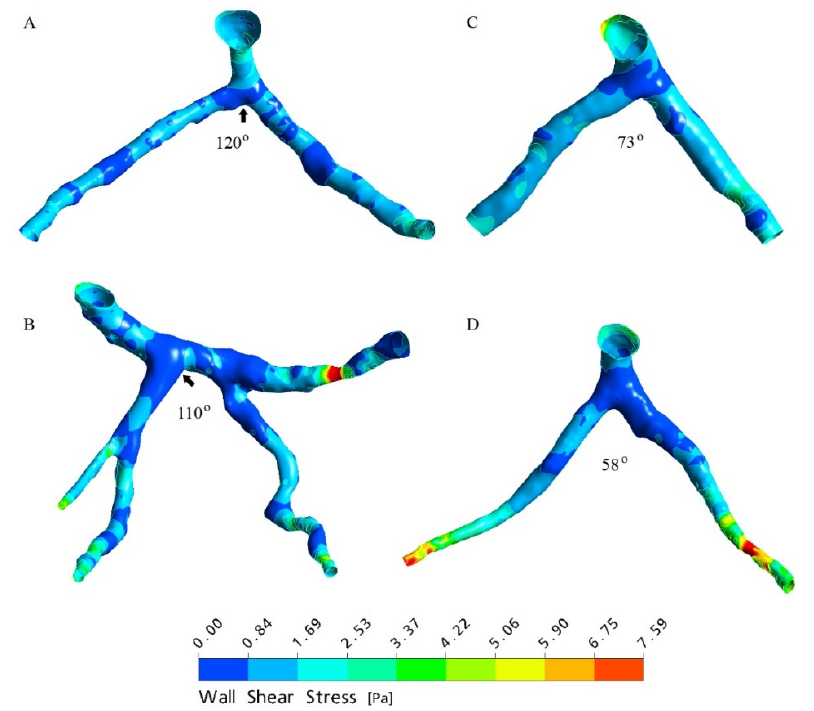
Figure 7. Wall shear stress observed with variable angles of the realistic left coronary artery models generated at peak systolic phase of 0.4 s. ( A ) and ( B ) refer to models with wide LAD-LCx angles, while ( C ) and ( D ) refer to models with narrow LAD-LCx angles. Arrows refer to the low wall shear stress distributions at large bifurcations. Reprinted with permission from Chaichana et al. [11] 2011, Elsevier.